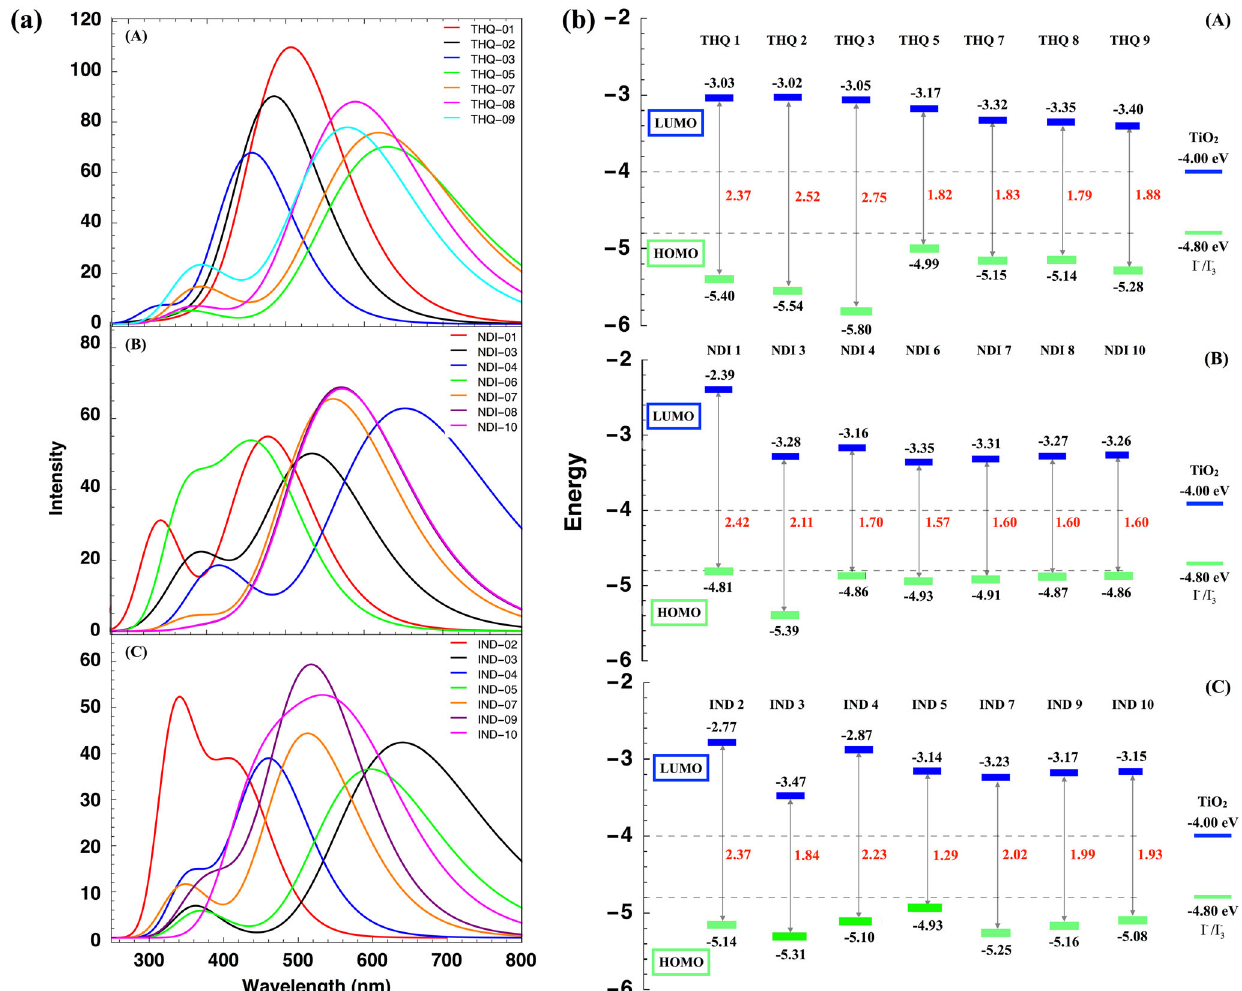
Fig. 2 ( a ) Simulated absorption spectra and (b) Energy diagram of HOMO and LUMO along with energy levels of TiO 2 and iodine electrolyte for the designed “ lead dyes ” of Tetrahydroquinoline ( A ), N,N ′ -dialkylaniline ( B ), and Indoline ( C )